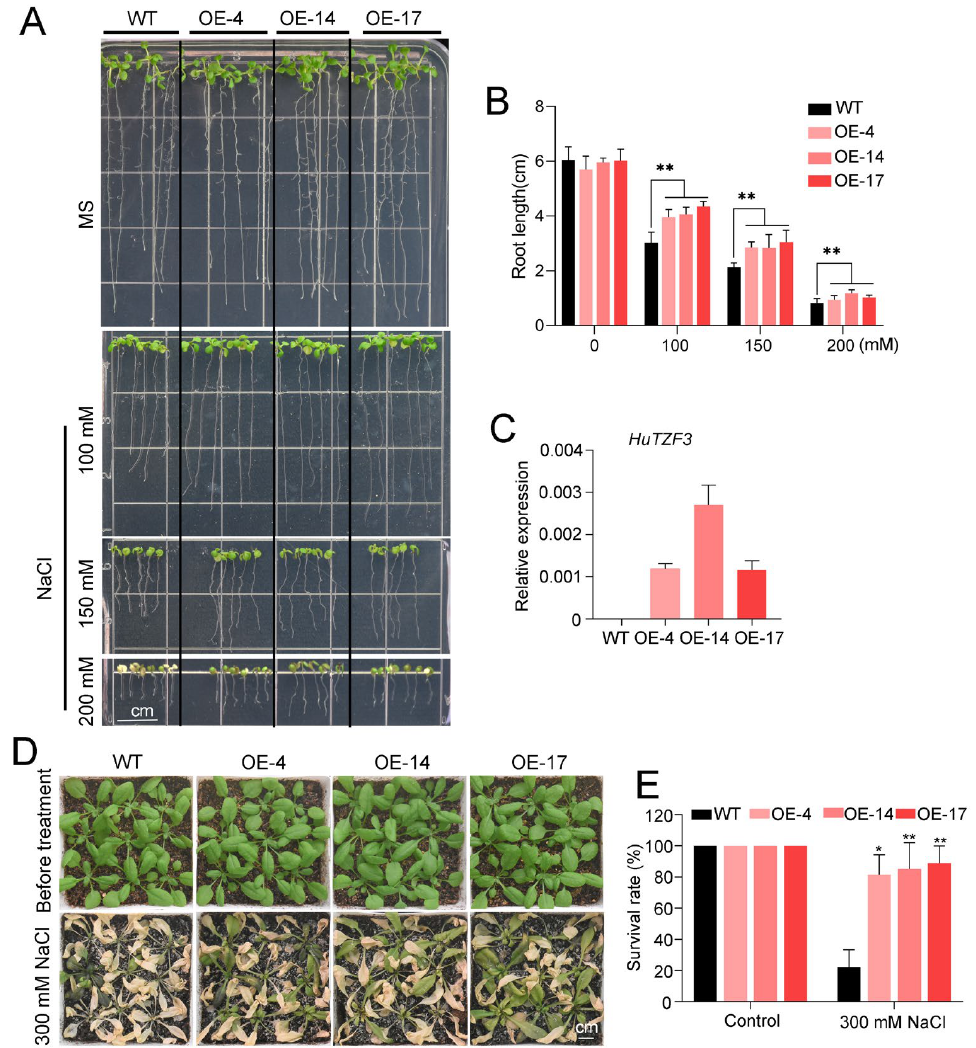
Figure 3. Heterologous expression of HuTZF3 improved salt tolerance in Arabidopsis. ( A , B ) Phenotype of seedlings’ root growth ( A ) and statistical analysis of primary root length ( B ) on MS medium with NaCl. Five-day-old Arabidopsis seedlings were transferred to MS medium, containing 0, 100, 150, and 200 mM NaCl and cultured for 7 days. The scale bar is 1 cm. ( C ) The expression level of HuTZF3 in the wild type (WT) and overexpressed HuTZF3 transgenic Arabidopsis lines. AtActin2 was used as the internal reference gene. ( D , E ) Four-week-old Arabidopsis of WT and overexpressing HuTZF3 lines were subjected to 300 mM NaCl treatment ( D ), and their survival rate ( E ). The scale bar is 1 cm. The experiments were performed three times with similar results. Values are means ± SD ( n = 30 plants). Asterisks show the values that are significant compared to WT. * p < 0.05, ** p < 0.01 according to the Student’s t - test.